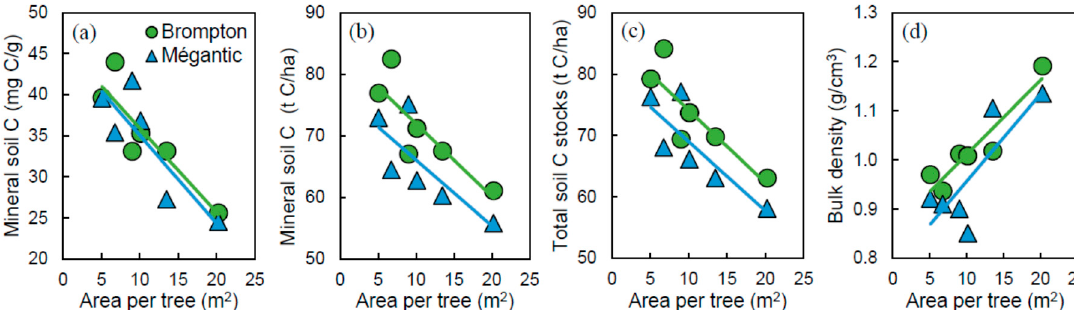
Figure 5. Site-specific linear relationships between the area per tree at planting and ( a ) mineral soil C concentration (0–20 cm layer), ( b ) mineral soil C stocks (0–20 cm layer), ( c ) total soil C stocks (mineral soil + O horizon) and ( d ) mineral soil bulk density (0–20 cm layer). Only relationships with p < 0.1 are presented. Fit and significance level of the relationships are the following for panel ( a ): Brompton site (R 2 = 0.80, p < 0.05), Mégantic site (R 2 = 0.74, p < 0.05); for panel ( b ): Brompton site (R 2 = 0.71, p < 0.05), Mégantic site (R 2 = 0.62, p = 0.06); for panel ( c ): Brompton site (R 2 = 0.74, p < 0.05), Mégantic site (R 2 = 0.69, p < 0.05): for panel ( d ): Brompton site (R 2 = 0.88, p < 0.01), Mégantic site (R 2 = 0.67, p < 0.05).